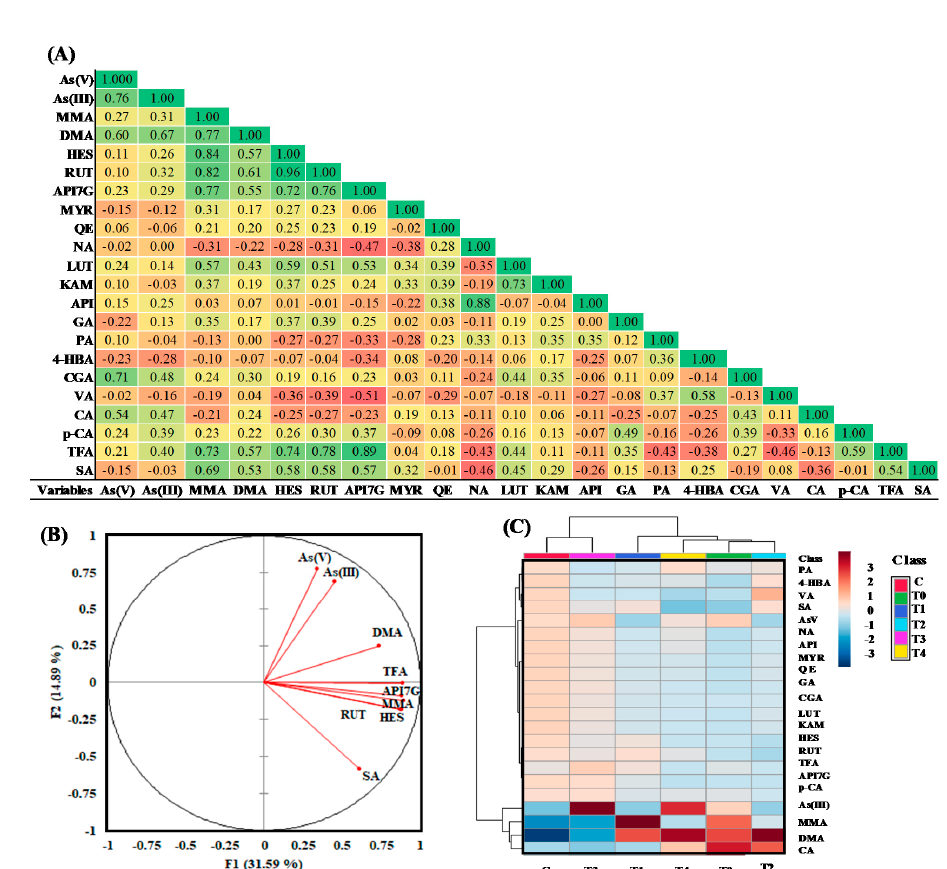
Figure 1. ( A ) Correlation analysis between arsenic species, phenolics, and flavonoids of rice grains. ( B ) Principal component analysis (PCA) biplot plot and ( C ) correlation heatmap, distinguishes different treatment groups based on arsenic species, phenolics, and flavonoids contents of rice grain. Treatments, C and T0, indicate untreated control, and 10 mg kg − 1 As treated group, respectively. T1, T2, T3, and T4 denote combined treatments, 10 mg kg − 1 As + 10 mg kg − 1 P, 10 mg kg − 1 As + 20 mg kg − 1 P, 10 mg kg − 1 As + 30 mg kg − 1 P, and 10 mg kg − 1 As + 40 mg kg − 1 P, In the PLS-DA scores plot, treatments C and T3 only formed distinct individual clus- ters, while all other treatments clustered together separately. The variable importance on projection (VIP) score plot was derived from the PLS-DA models to identify compounds responsible for clustering based on their VIP score [26]. VIP score plot showed MMA and As (III) had the highest magnitude of VIP scores, respectively (Figure 2B) among the quan- tified species of As, phenolic acids, and flavonoids. The results of these studies indicate that MMA and As (III) are the main As species of the rice grain, which are highly influ- enced in response to As and P application. 3. Discussion The phytotoxicity of As is well known. The toxicity of As in plants varies with its speciation, plant species, and with other soil factors controlling As accumulation in plants [1]. In plants, As causes phytoxicity by increasing production of ROS either directly dur- ing conversion of As (V) to As (III) or indirectly via inactivation of the enzymatic antioxi- dants by binding to their thiol group [27]. External phosphate fertilization has been found to be useful in alleviating As toxicity in rice [18,28]. It has been proved that phosphorous is an important parameter in the paddy field for arsenic solubility in soil and its uptake by plants. Both As and phosphorous are the common members of the pnictides group and